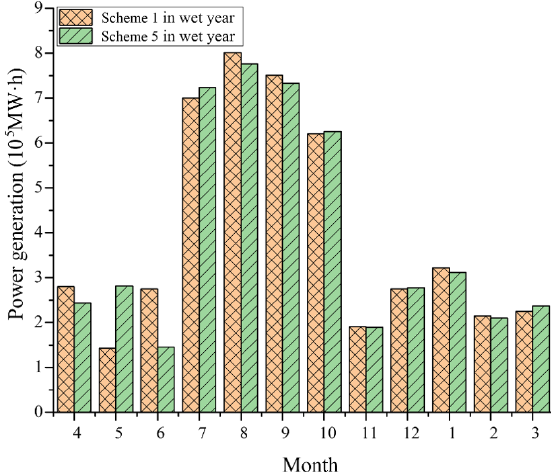
Figure 9. Diagram of electricity generation in a wet year.